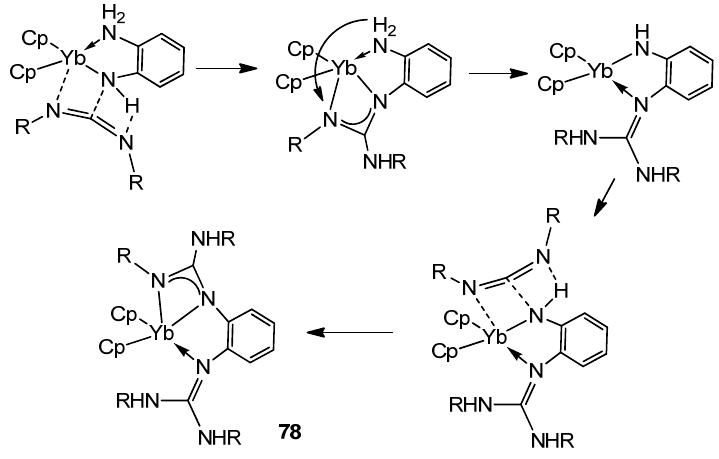
Figure 48. NH-assisted insertion of carbodiimides in amido ytterbium compounds.